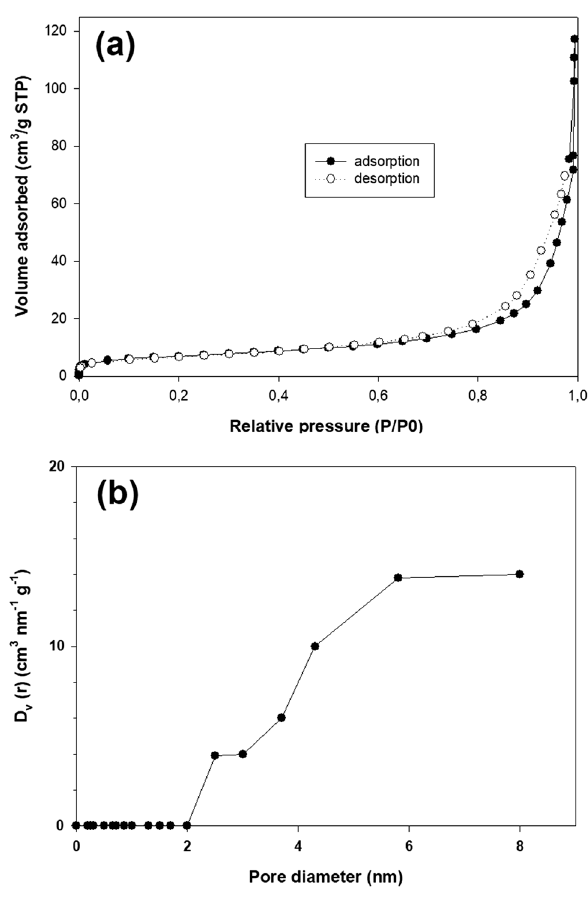
Figure 8. ( a ) Nitrogen adsorption–desorption isotherms of the Na-P 1 zeolite and ( b ) pore size distribution